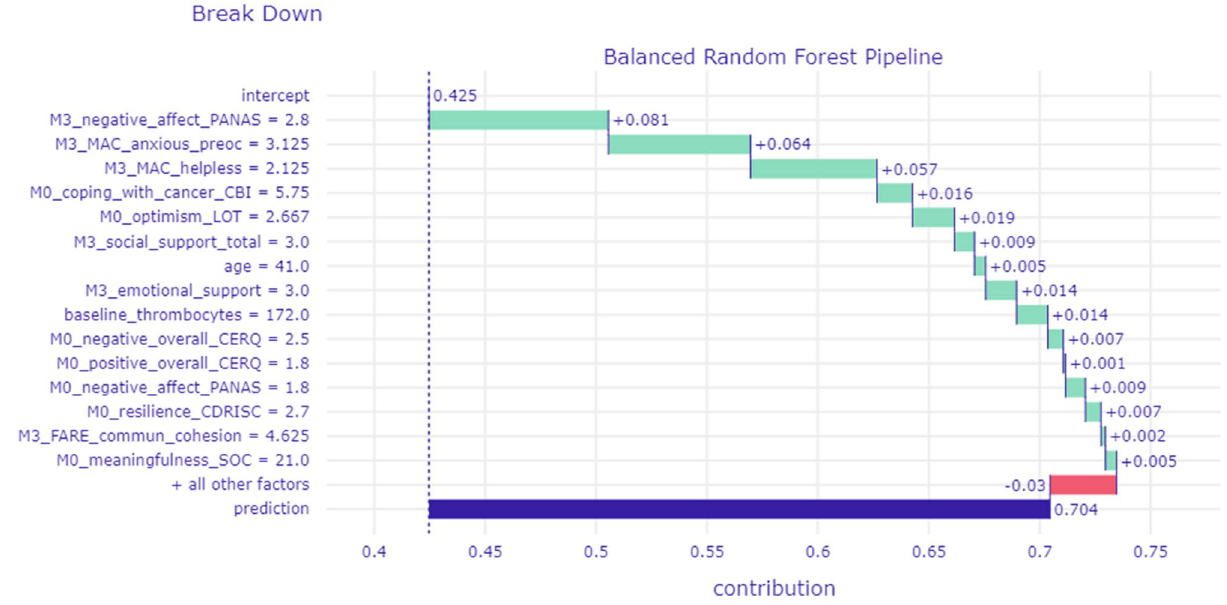
Figure 2. BD profile of a patient who displayed deteriorated mental health status at M12. Prediction probability is shown on the horizontal axis (Stable-Good mental health = 0, Deteriorated Mental Health = 1). This patient was given a high probability of membership in the Deteriorated Mental Health class (0.704). Actual patient scores on each predictor variable are shown on the left-hand side. A positive value assigned to a given score (green bars) indicates the degree of its contribution toward a prediction of Deteriorated Mental Health. A negative value (red bars) indicates the degree of a given score’s contribution away from a prediction of Deteriorated Mental Health (i.e., increasing the probability of assigning this patient to the Stable-Good Mental Health class).